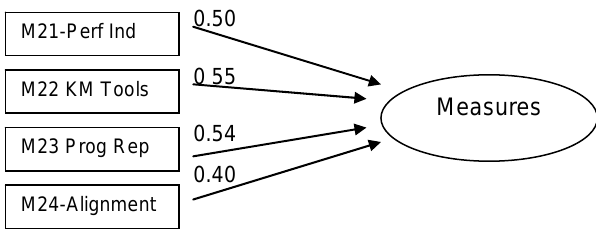
Figure 7: Relative weights for Measures indicators Correlation between the six main